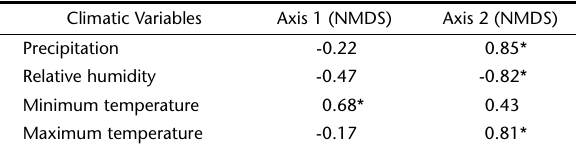
Table III. Pearson’s Correlation between environmental variables and the NMDS scores of the Collembola guild in João Câmara, Rio Grande do Norte, Brazil. * p <